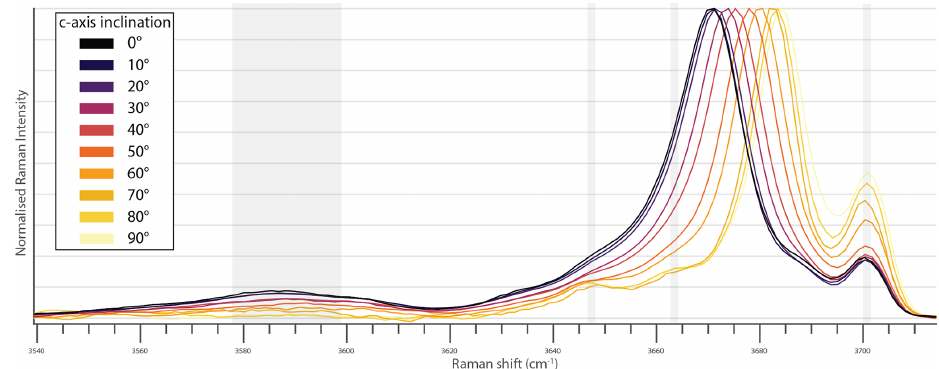
Figure 7. Raman spectra as a function of c -axis inclination for the SCGSM study. Grey rectangles highlight bands at 3590, 3688, 3656, and ∼ 3663cm − 1 .